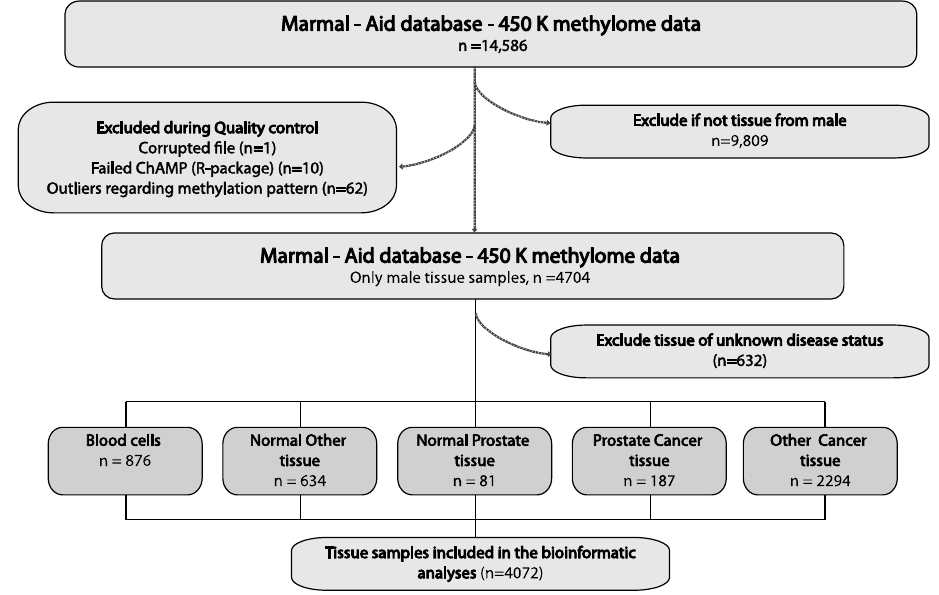
Figure 1. Selection of samples and biomarker candidates. Tissue sample selection for bioinformatics analyses. We selected male samples ( n = 4072) with known disease status to ensure specificity for prostate cancer (PCa) versus other cancers and non-malignant tissues.